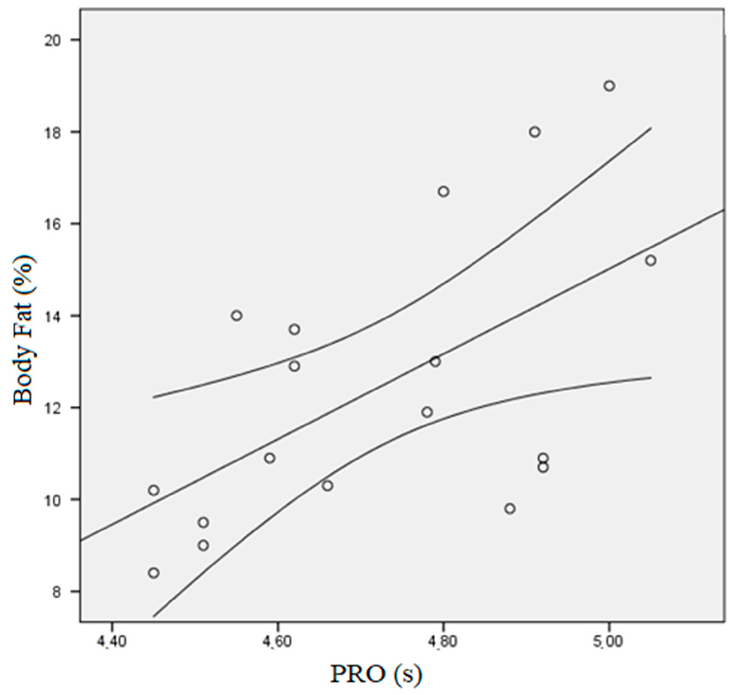
Figure 5. Scatter plot between Body Fat and PRO. PRO = pro-agility test. The middle line represents the median and the parabolic lines represent the 95% confidence interval.